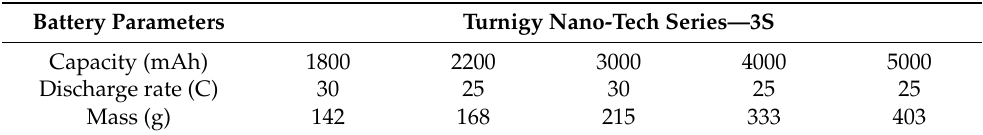
Table 1. Considered LiPo batteries [42].